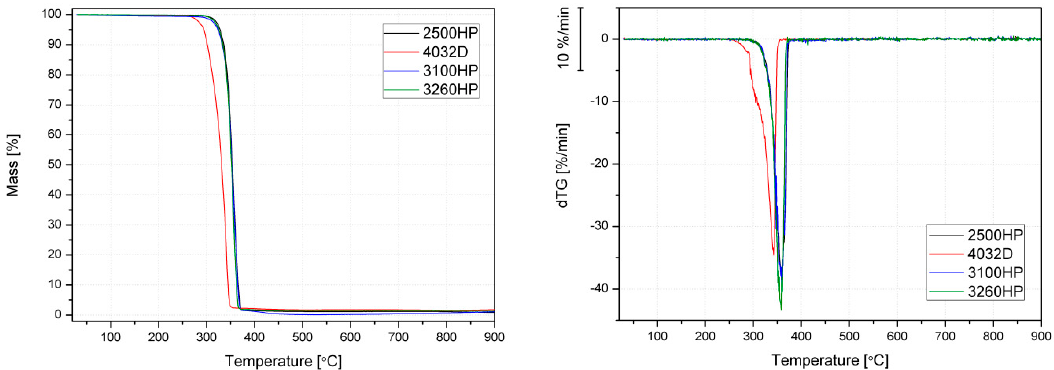
Figure 6. TG (changes of samples’ mass in function of temperature) and the first derivative of the obtained TG curves (dTG) of PLA grades.